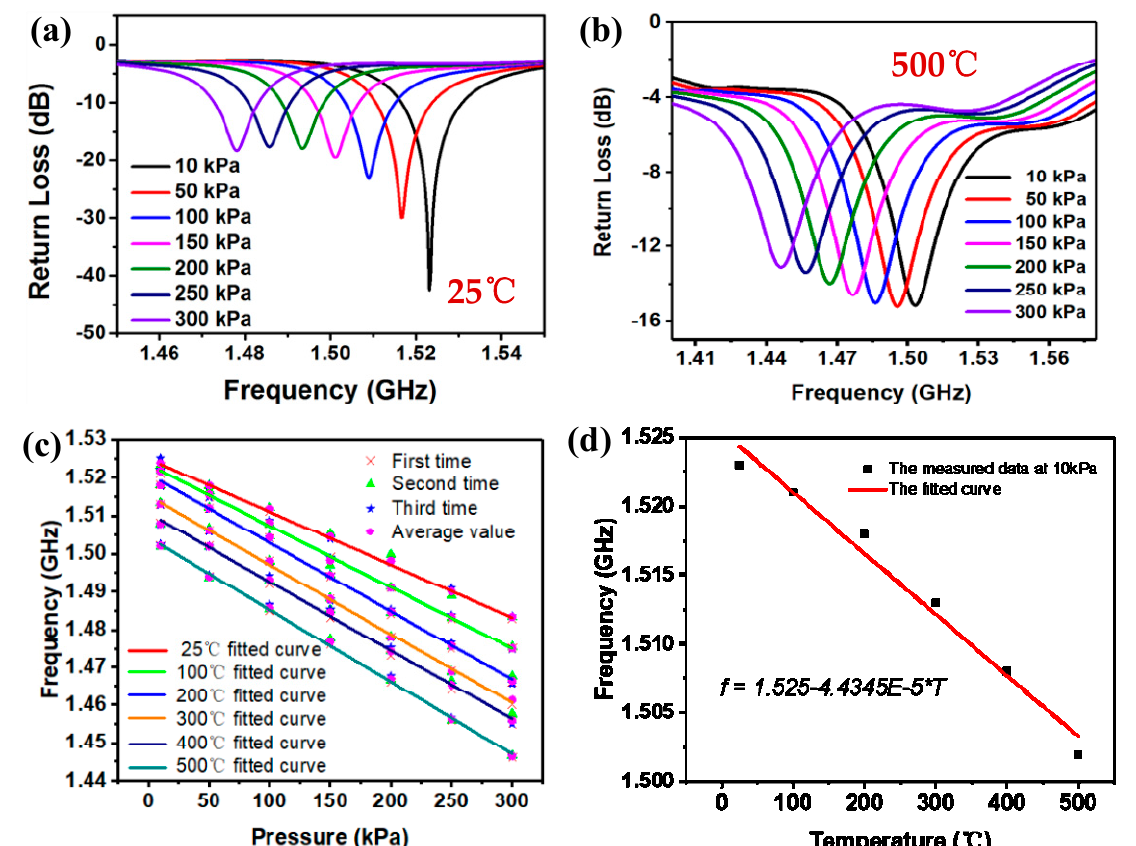
Figure 8. ( a ) Resonant frequency curves within the pressure of 10–300 kPa at 25 °C; ( b ) resonant frequency curves within the pressure of 10 − 300 kPa at 500 °C; ( c ) linear fitting curves of pressure at 25 − 500 °C; ( d ) linear fitting curves of temperature at 10 kPa.